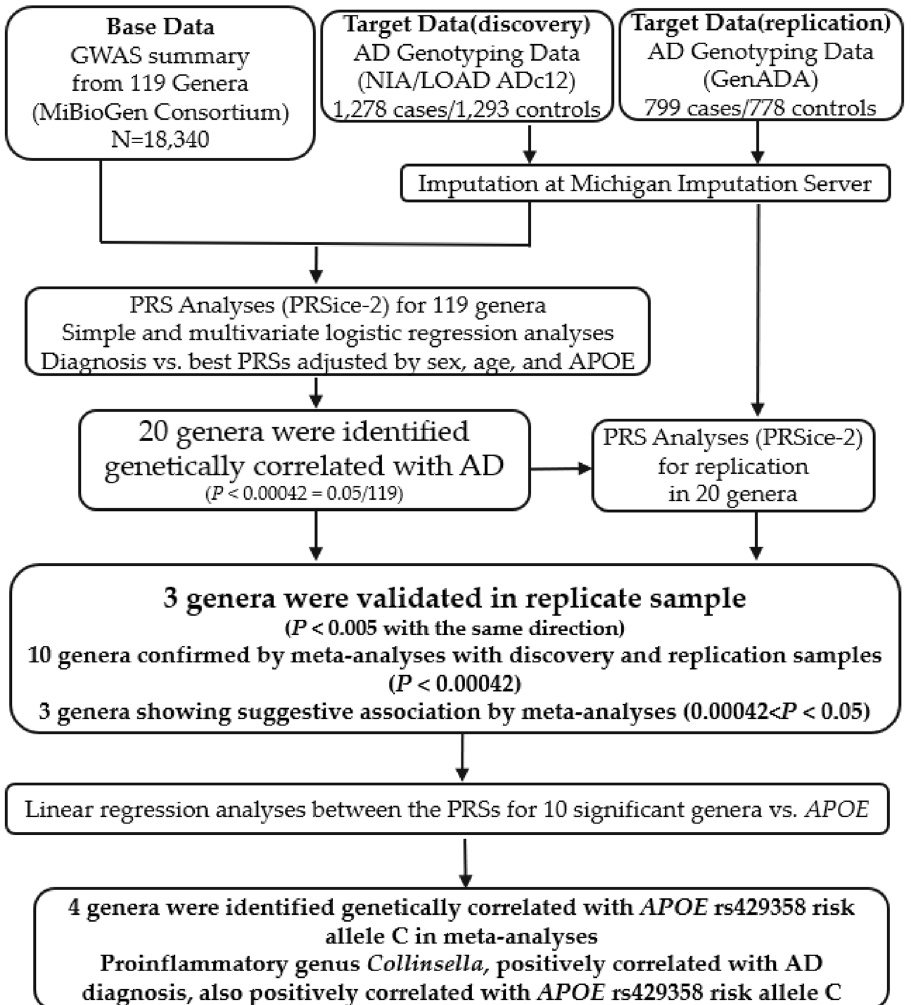
Figure 1. Study design flowchart. In the PRS analysis, “Base” data is used to provide effect sizes for SNPs shared with individuals in the “Target” data. Using PRSice-2, 20 genera were found to be significantly genetically associated with AD diagnosis in the discovery sample. Three genera were validated in the replication sample, and ten were confirmed by a meta-analysis from discovery and replicate samples. Linear regression analyses were used to determine the genetic correlation between the PRSs for ten significant genera and APOE genotyping. Three genera were identified as genetically correlated with APOE rs429358 risk allele